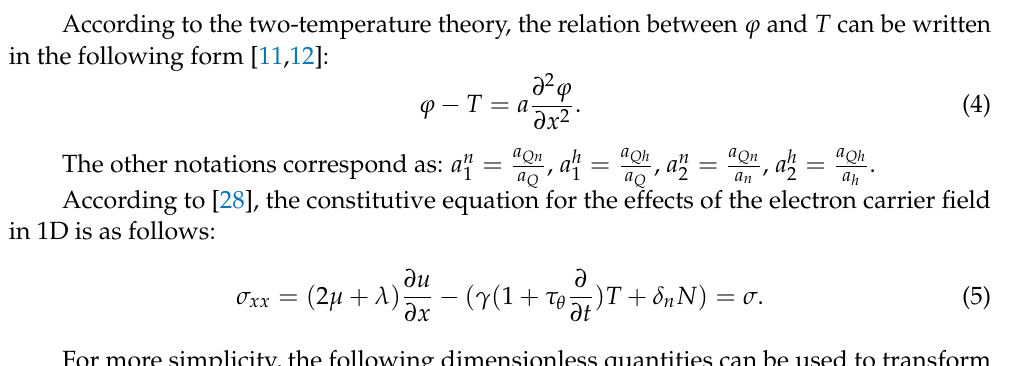
Figure 1. Temporal profile of the laser pulse.